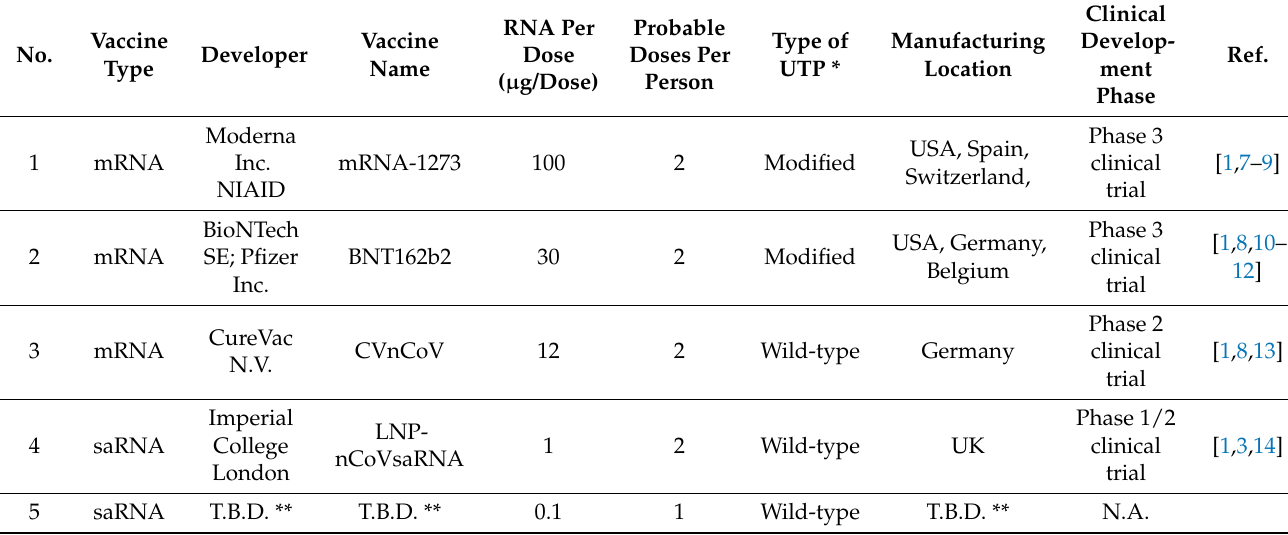
Table 1. List of RNA vaccines considered in this